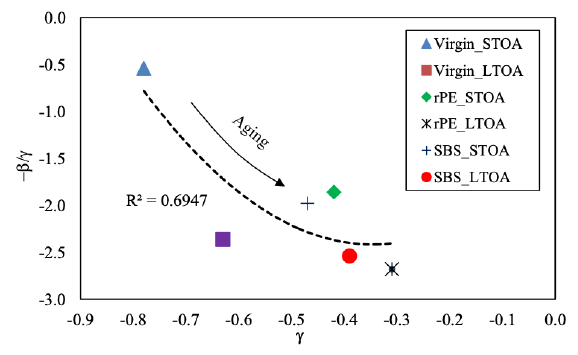
Fig. 7. Variation of |E*| master curve shaper parameter decreasing frequency. This result is also consistent with a previous study [52].